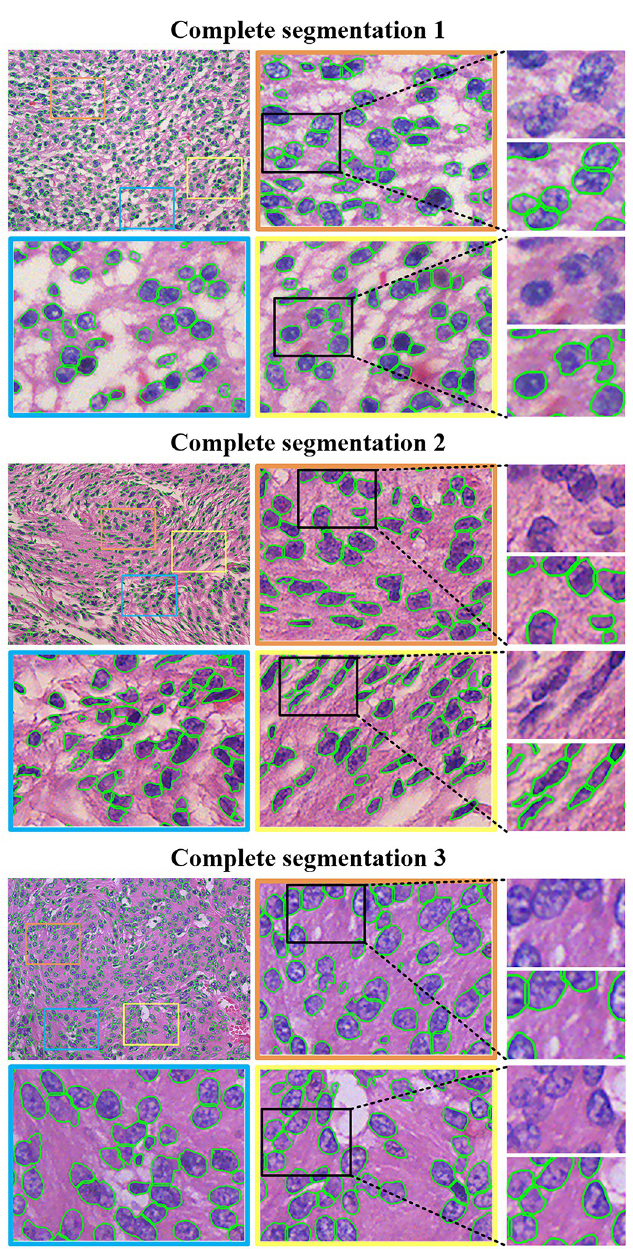
Fig 8. Complete segmentation performance. The images with orange, blue, or yellow borders are the results of partial enlargement; the third column shows even greater segmentation details.